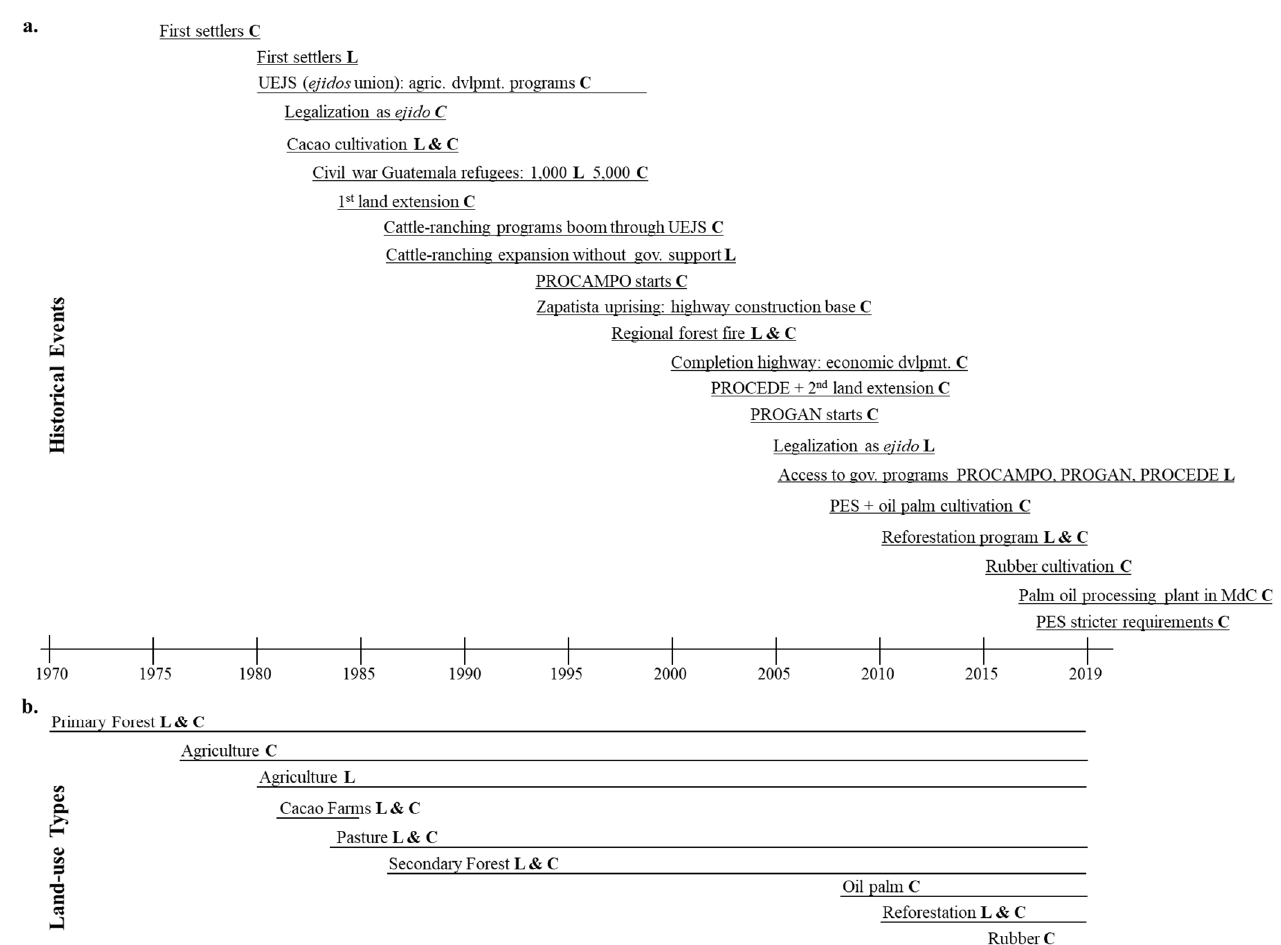
Figure 7. Timeline of historical events and land-use types from 1976–2019 in the study site. ( a ) Main historical events related to land-use change in Chajul (C) and Loma (L); line length represents the duration of an event such as a governmental program, while events underlined only in first letter indicate conjunctural events that occurred in a specific year, such as the year settlers arrived or land extensions were granted. ( b ) Main land-use types across time in Chajul and Loma. Source: figure adapted from Speelman et al. [46] and elaborated with this article’s data.